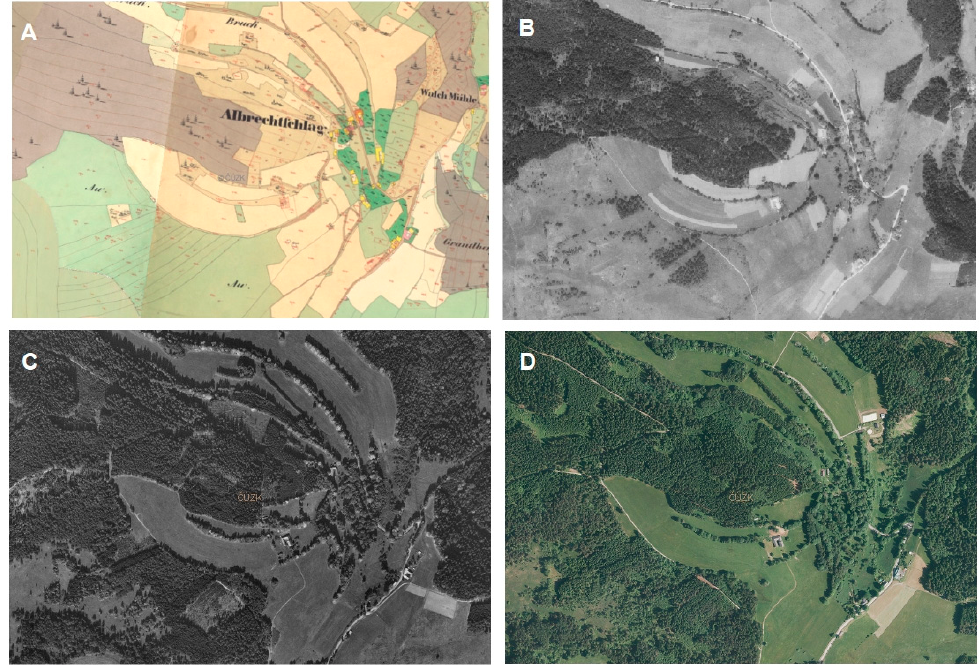
Figure 3. The example of sources used for the analysis of real land use data (( A )—stable cadastre, ( B )—aerial photograph 1950s, ( C )—aerial photograph 1990, ( D )—aerial photo- graph 2019) .